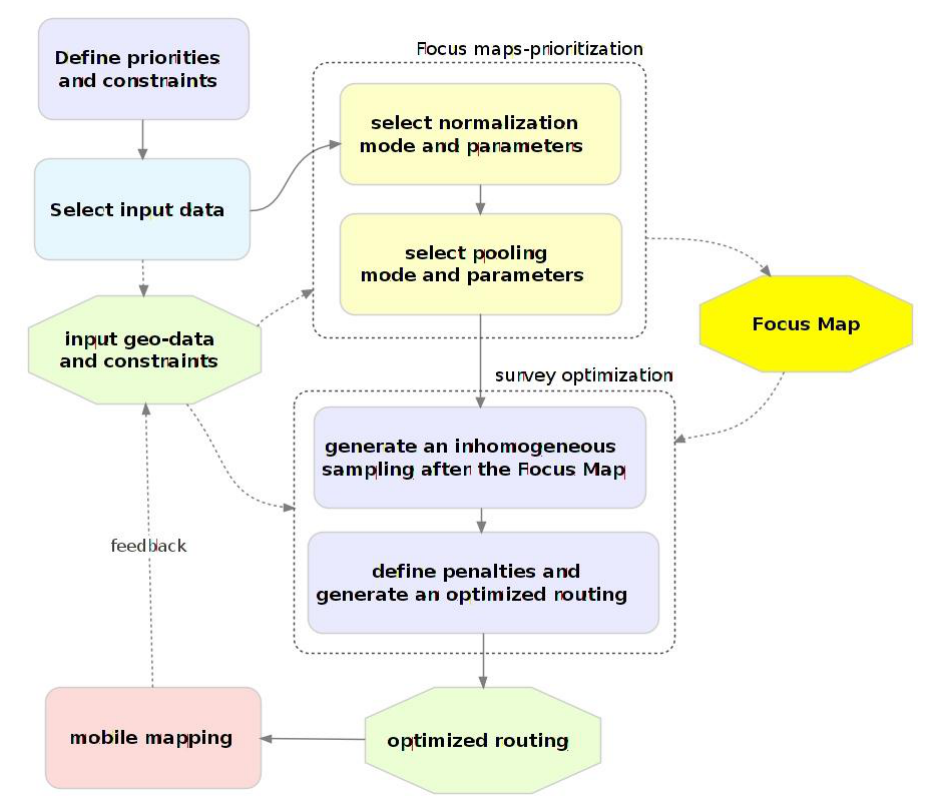
Figure 3. Diagram showing the prioritization work-flow with iterative multi-stage